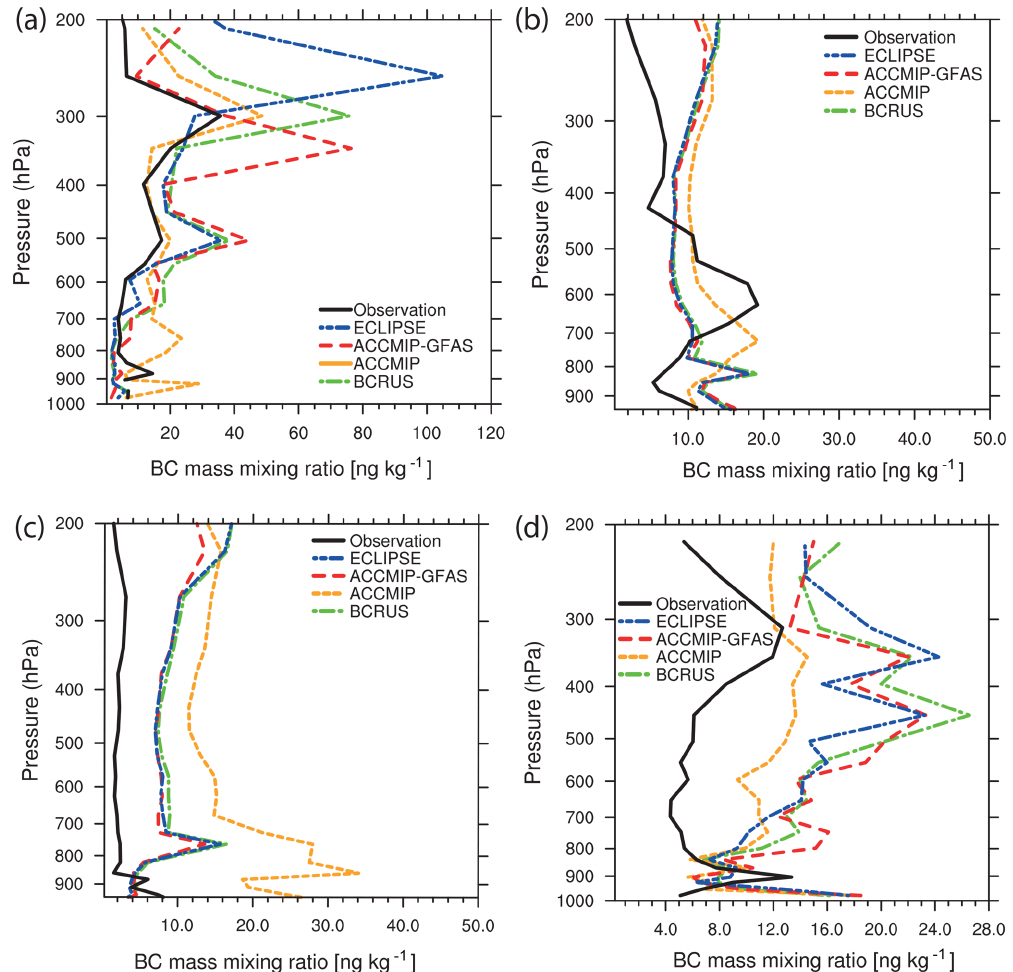
Figure 12. As in Fig. 10, but for summer campaigns (June–July–August). (a) ARCTAS summer campaign in June–July 2008. (b) HIPPO-4 campaign in June–July 2011. (c) HIPPO-5 campaign in August–September 2011. (d) ACCESS campaign in June 2012. Table 4. Measurements overview. For aircraft campaigns, the location of the airfield is given unless no specific base can be defined (denoted by ∗